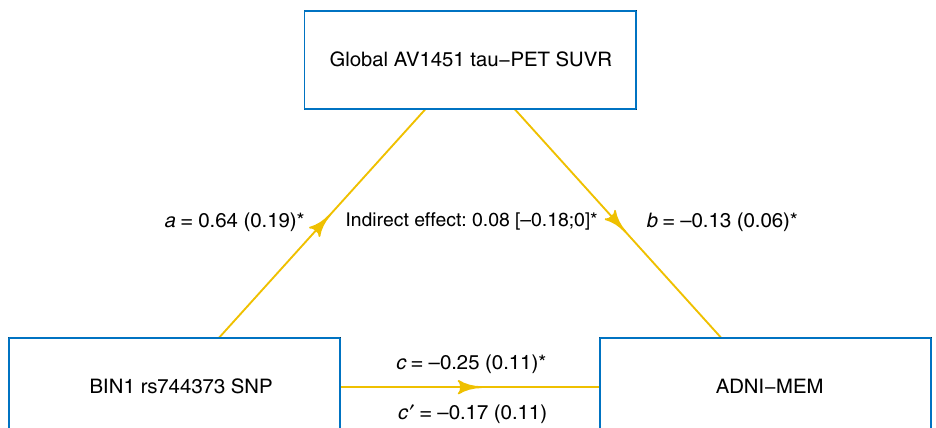
Fig. 6 Tau mediates effects of BIN1 rs744373 on memory impairment. Path diagram of the mediation model (assessed on the full sample of n = 89 subjects), showing that associations between BIN1 rs744373 risk-allele carriage and worse memory are mediated via global AV1451 tau-PET uptake. Path-weights are displayed as beta values with standard errors in brackets. All paths are controlled for age, gender, education, diagnosis, global AV45 amyloid-PET uptake, and ApoE ε 4 carrier status. Asterisks indicate p -values below 0.05. Signi fi cance of the indirect effect was determined using bootstrapping with 10,000 iterations